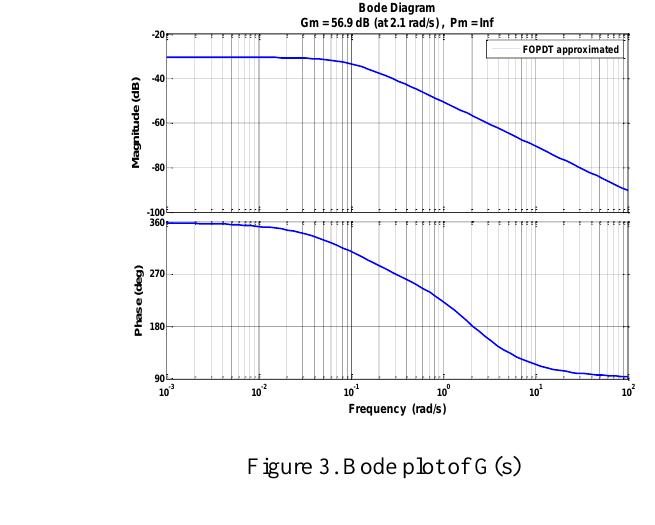
Bode Diagram Gm = 54.7 dB (at 1.63 rad/s) , Pm =